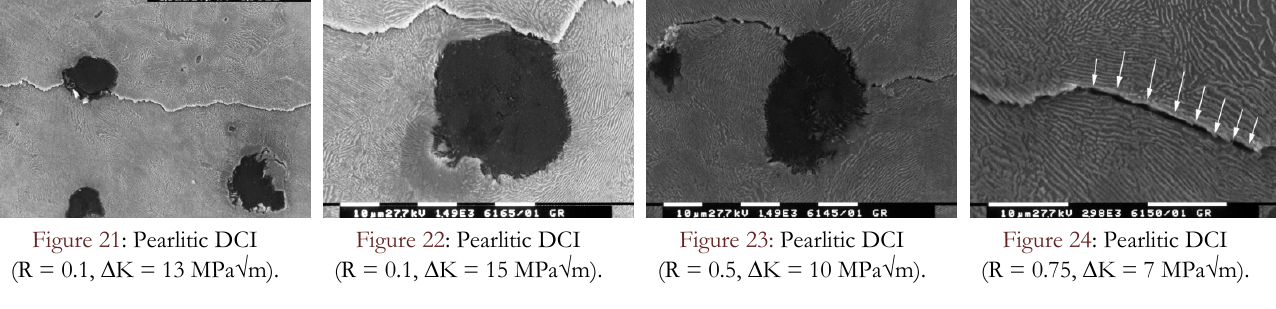
Figure 21: Pearlitic DCI (R = 0.1,  K = 13 MPa √ m).